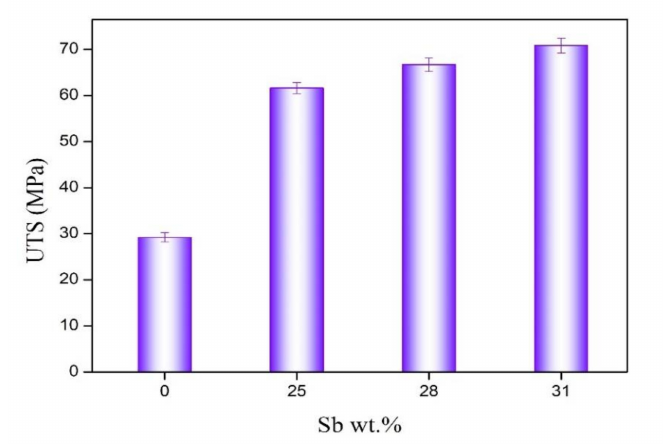
Figure 8. Ultimate tensile strength of Sn-3.0Ag-0.5Cu- x Sb solder alloy.